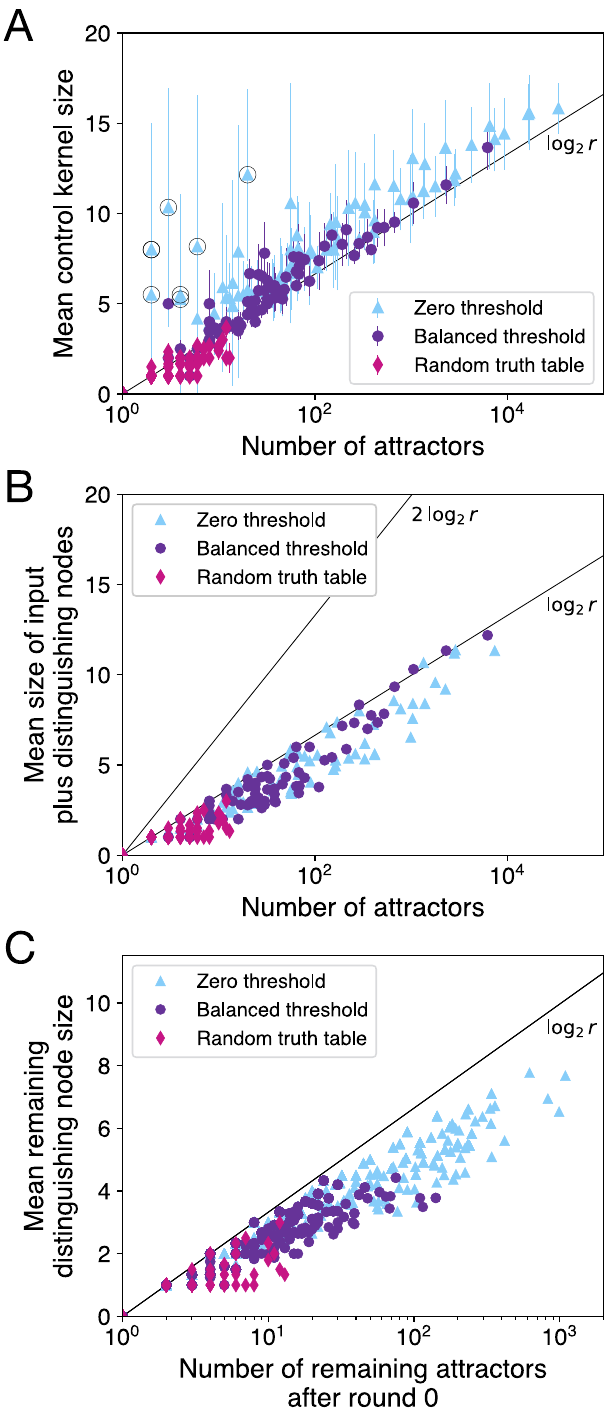
Fig. 9 Control kernels in random networks show similar characteristics to those seen in the biological cases. Here we choose networks of size 10, 15, and 20 from three ensembles: Erdös – Rényi networks with zero thresholds (azure triangles), Erdös – Rényi networks with balanced threshold inputs (dark purple circles), and p – K networks with random truth tables (pink diamonds). A Mean control kernel sizes are typically near the base-2 logarithm of the number of attractors. Compare to Fig. 1. Outliers, highlighted with a black circle, share a bias toward excitation that creates repellor fi xed points. B The fi rst-order approximation to control kernel size is typically below log 2 r and always below 2log 2 r . Compare to Fig. 8. C After fi xing input nodes in round zero, distinguishing node sizes are empirically bound by log 2 r . Compare to Fig.